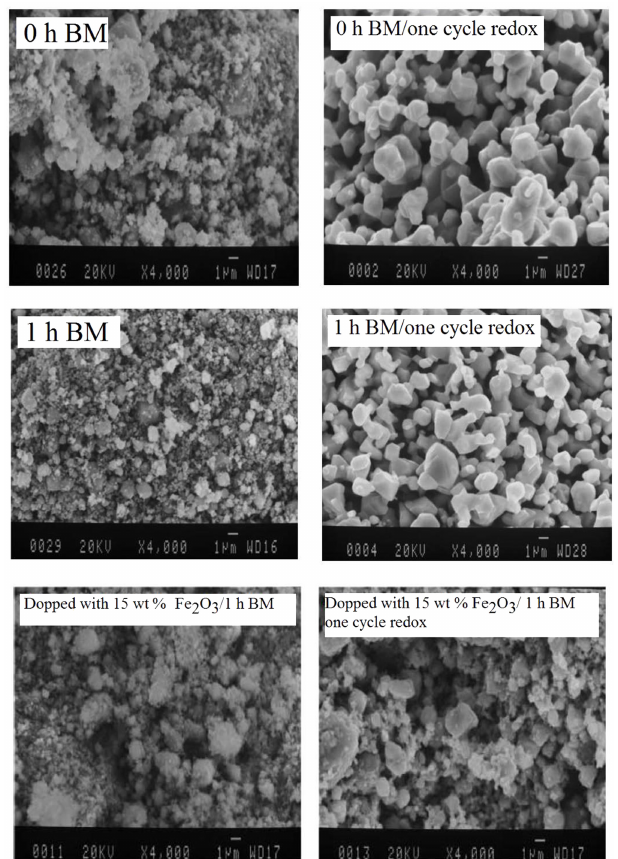
Fig. 3. SEM images of as-received Co 3 O 4 , Co 3 O 4 /1h BM and Co 3 O 4 - 15 wt% Fe 2 O 3 /1h BM before and after redox.